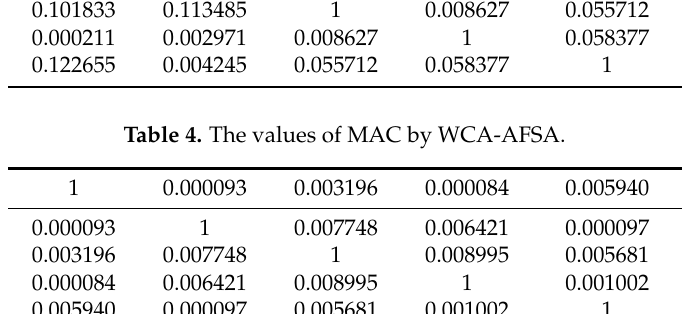
Table 4. The values of MAC by WCA-AFSA.